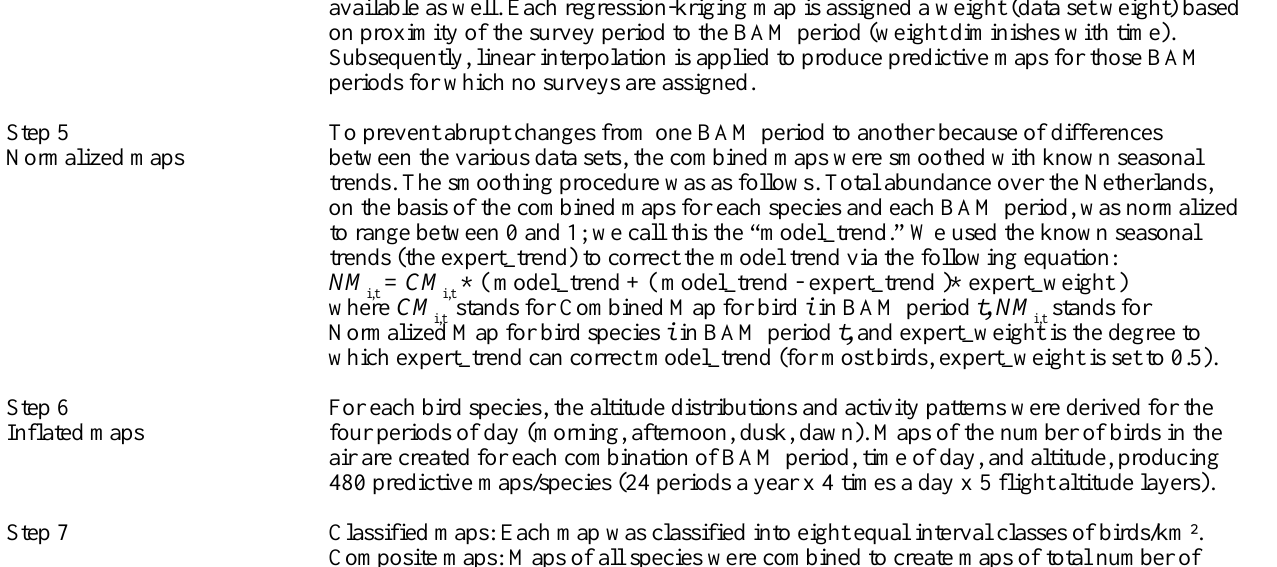
Classified maps: Each map was classified into eight equal interval classes of birds/km². Composite maps: Maps of all species were combined to create maps of total number of birds/km² and total mass/km². Summary table: The sum of birds was calculated for three regions/time of year, time of day, and altitude layer, for the top 10 most abundant